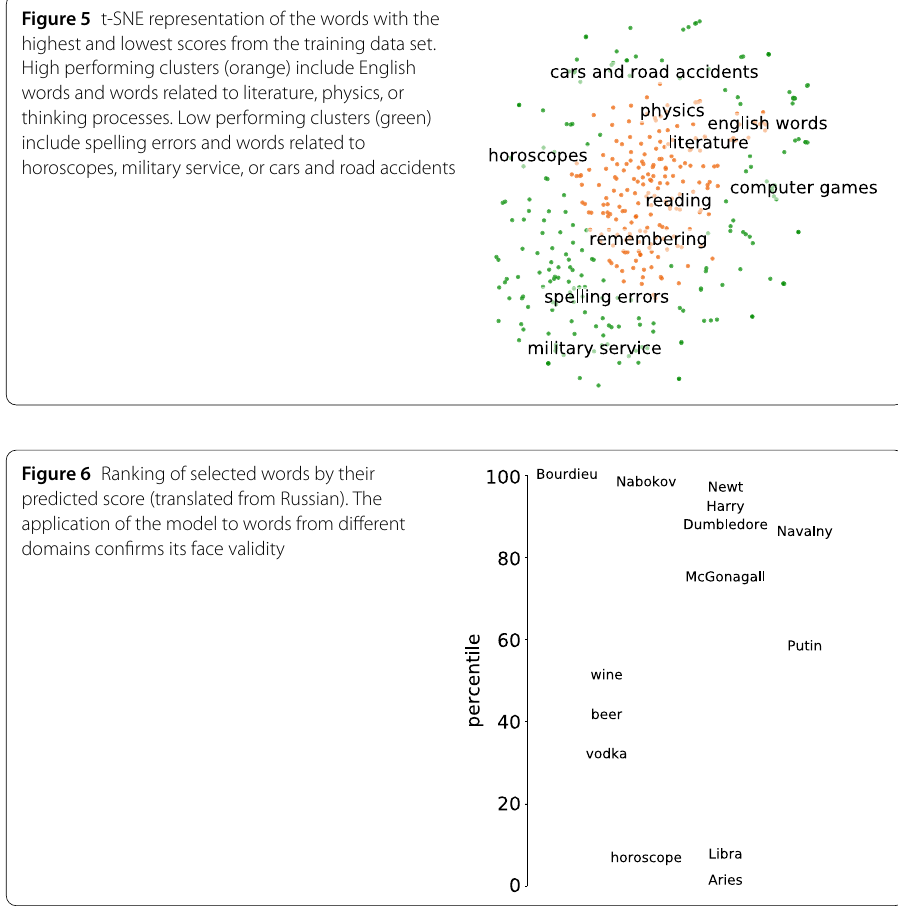
Figure 5 t-SNE representation of the words with the highest and lowest scores from the training data set. High performing clusters (orange) include English words and words related to literature, physics, or thinking processes. Low performing clusters (green) include spelling errors and words related to horoscopes, military service, or cars and road accidents